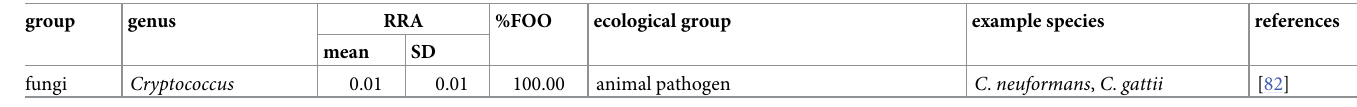
The relatively most abundant cellular microbial genera as quantified by metagenomics. For each taxon, we show its ecological group based on literature (for classification, see section Materials and methods: Functions of microbes ). Included in the table are taxa with a mean RRA � 0.01% in the metagenomics data. For each genus we provide examples of species identified from the North-European honey samples.